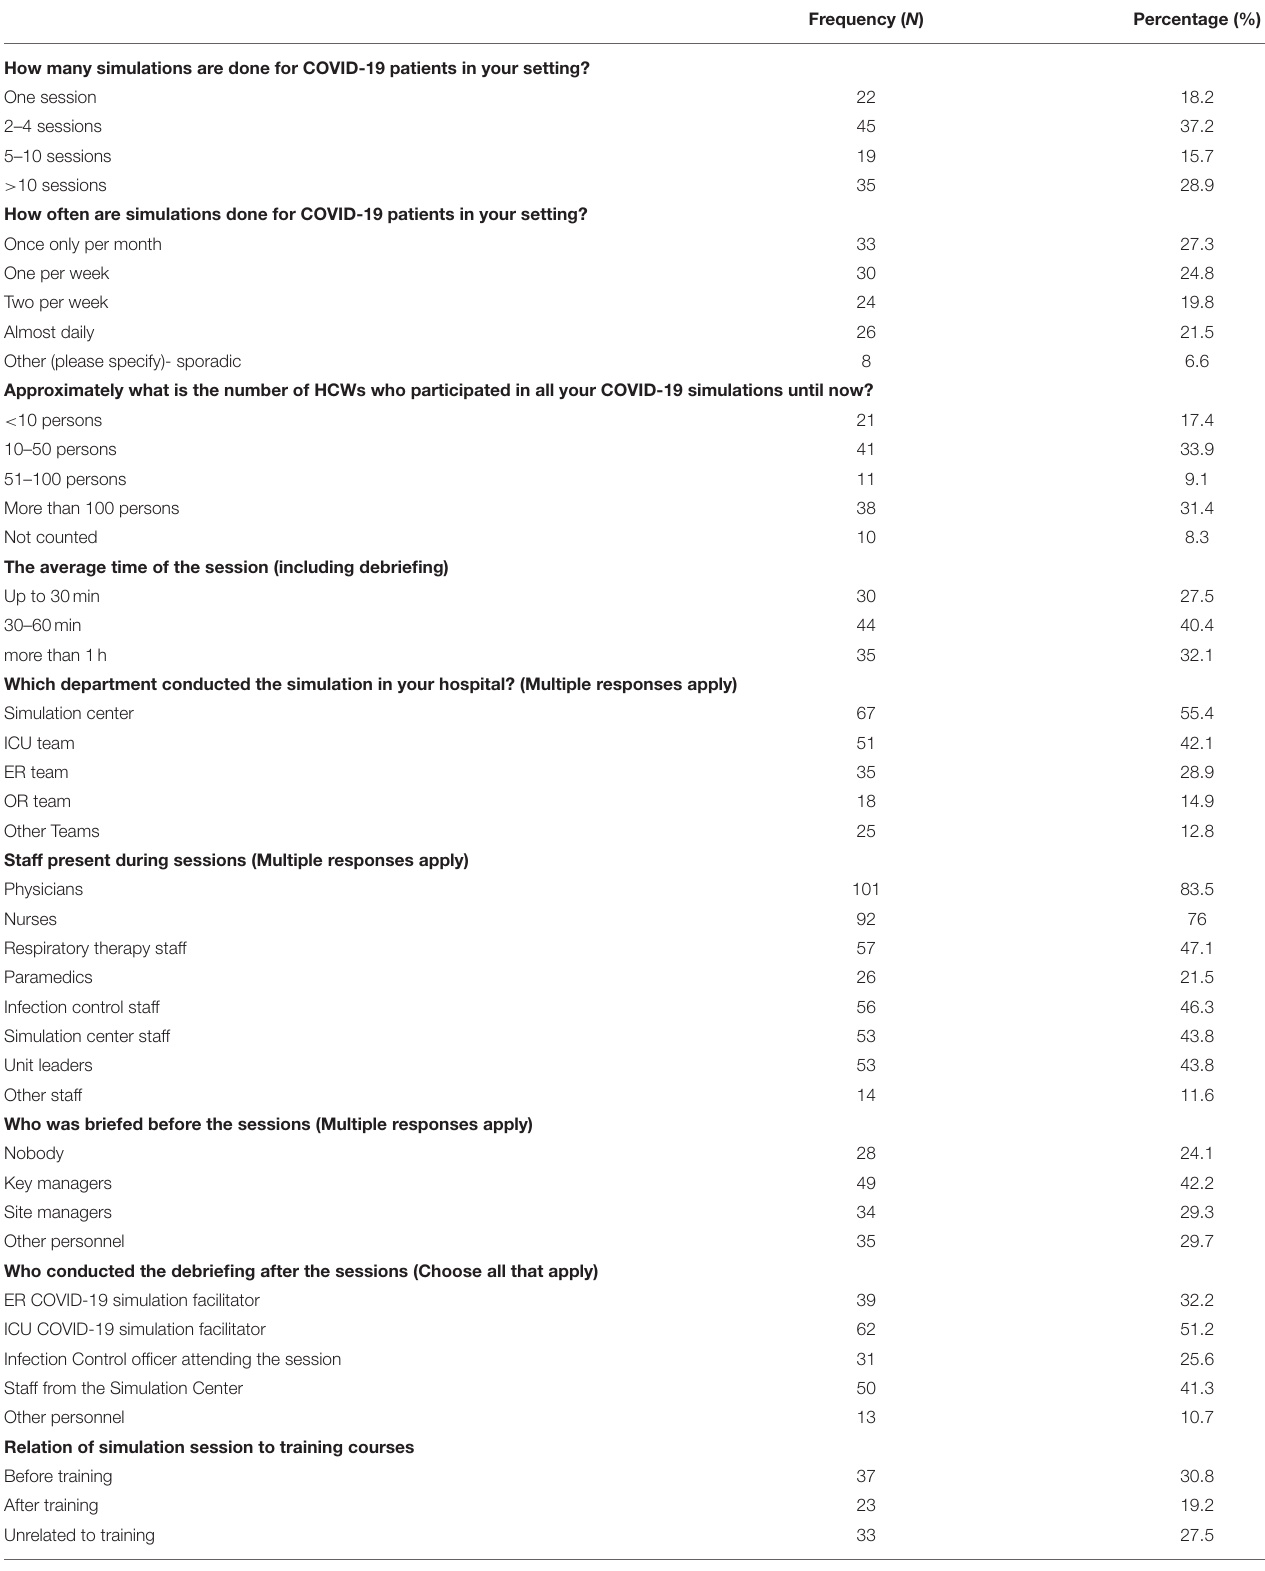
TABLE 2 | Description of COVID 19 simulation sessions (Drills) based on respondents ( N =